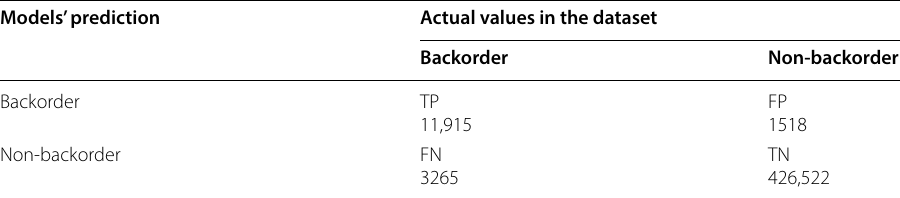
Table 5 Confusion matrix for GBM with ranged data Models’